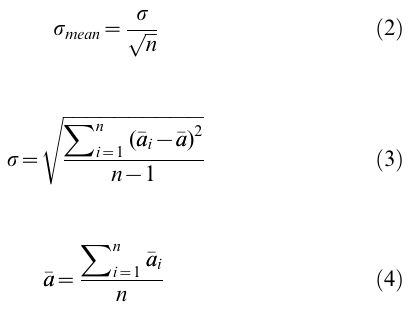
Figure S1 TSE refinement. a) Time evolution of R parameter (above), r (middle) and distance between the C a atoms of the turn N6-G9 (below) during one of the folding transitions along trajectory 6. The transition to the putative folded state is marked with the bold black line. b) The location on the free energy landscape of the putative folded structures shown in panel a) is highlighted with a black